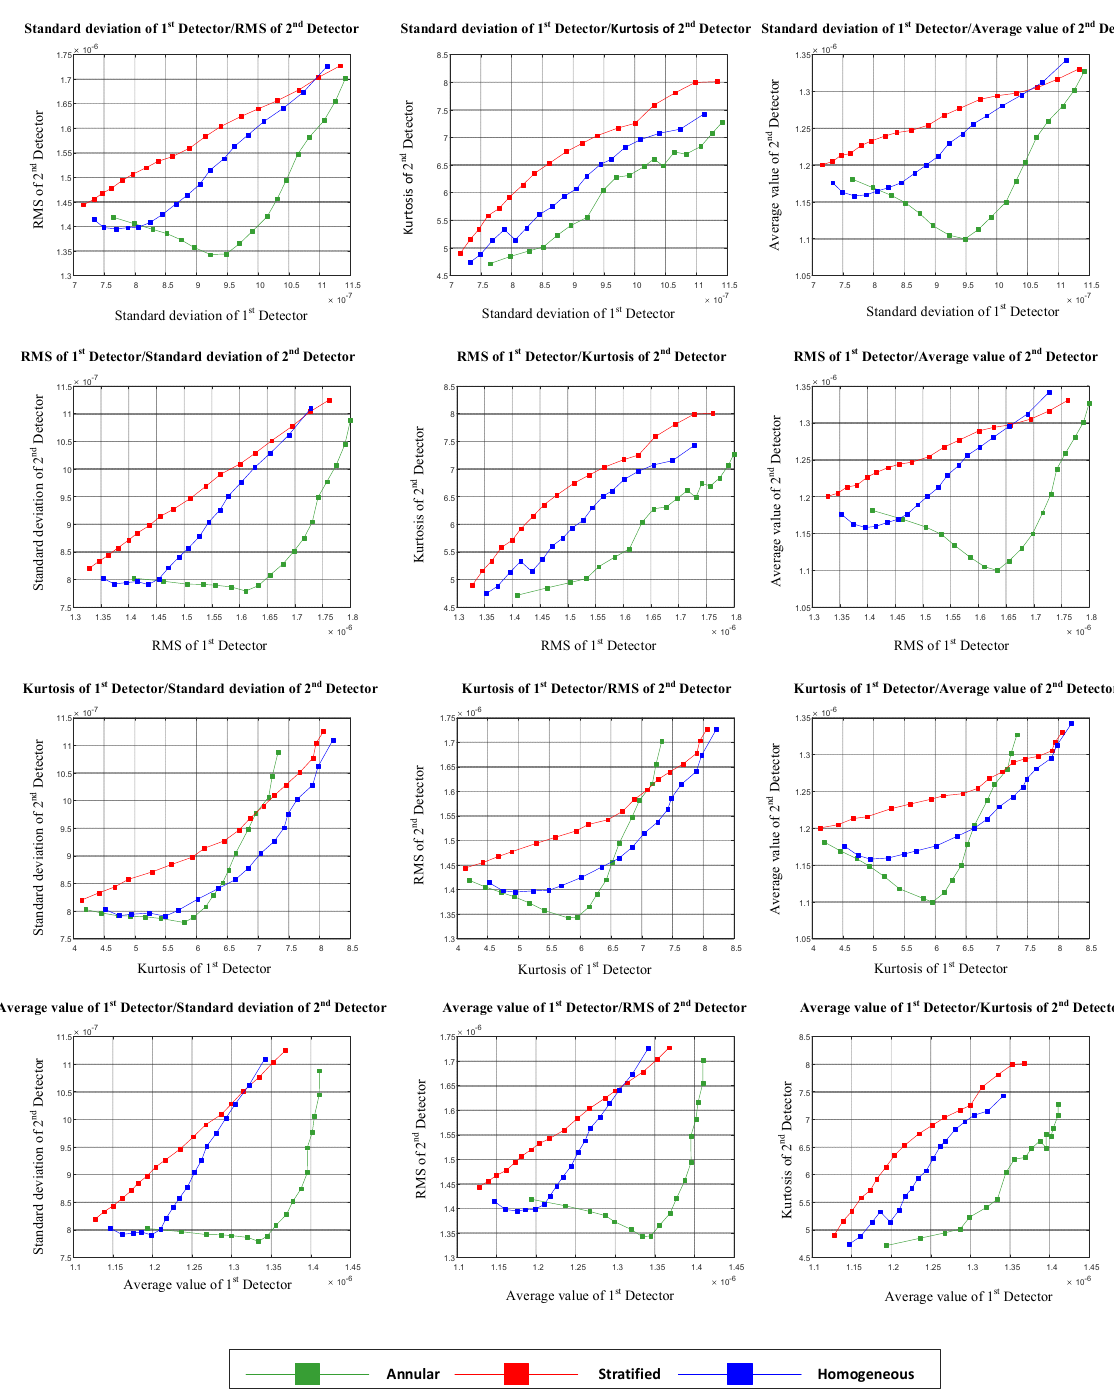
Figure 5. Different features extracted from each detector.